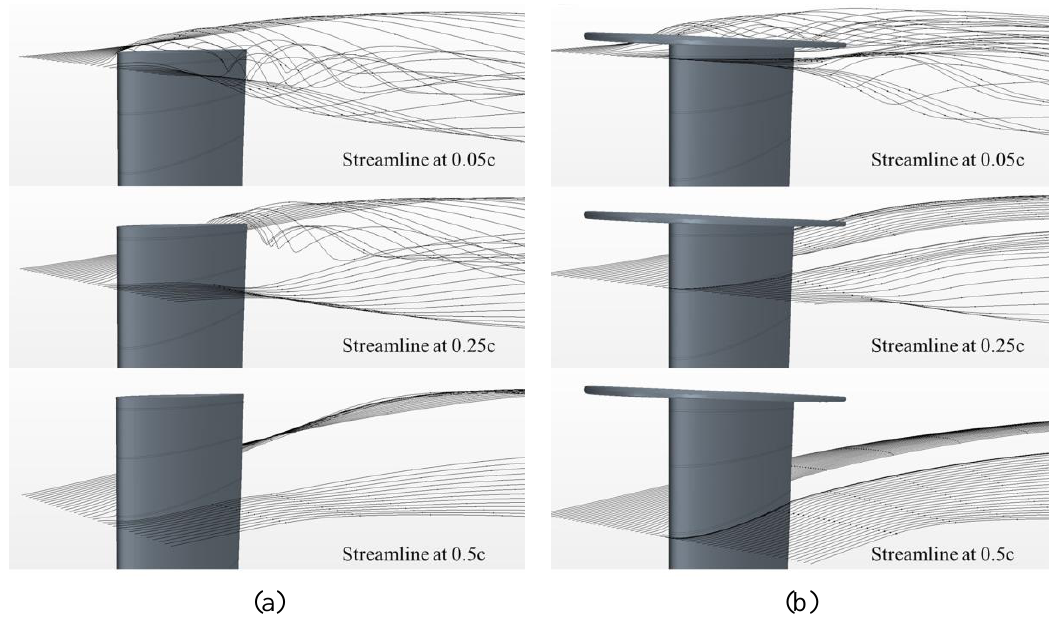
Figure 15. The streamline at different heights of the blade sections when the azimuthal angle is 88 ° : ( a ) without a bulkhead; ( b ) with a bulkhead.